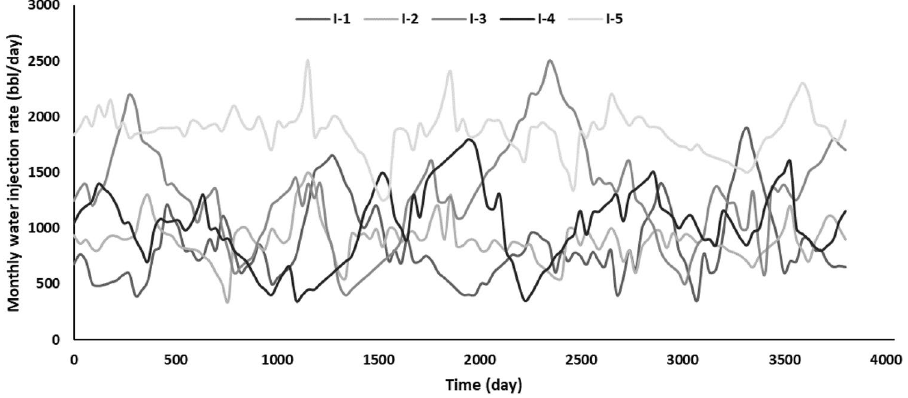
Fig. 13 An example of liquid injection rates in cases III and later. I 1 stands for injector 1 and others are represented with the same naming convention